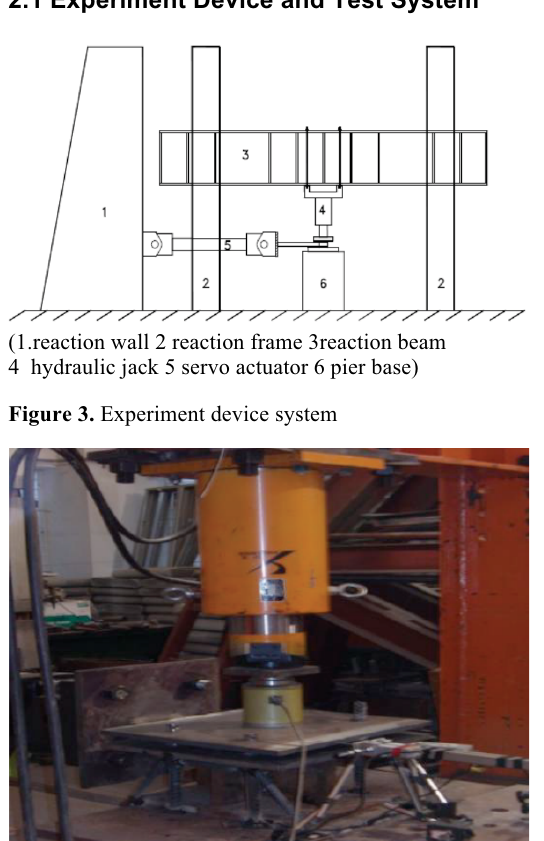
Figure 4. Experiment load